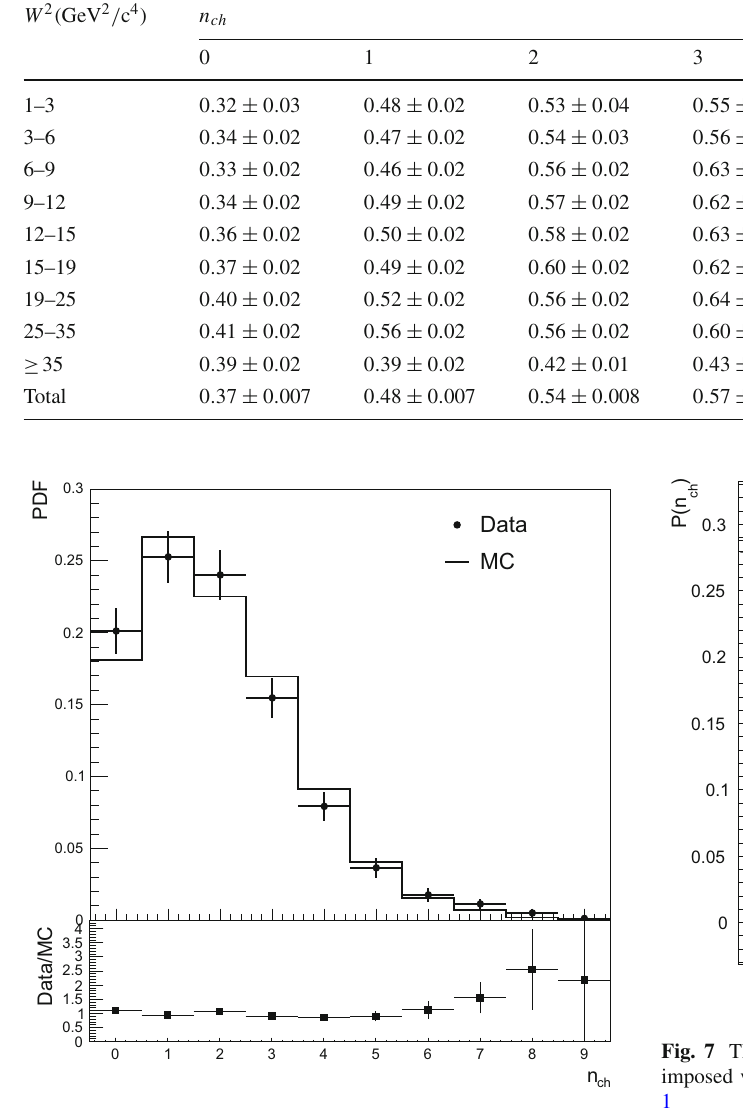
Fig. 6 Comparison between the PDF of the data and MC charged hadron multiplicities observed and MC simulated data. The efficiency correction is hereafter applied to the measured data distributions.